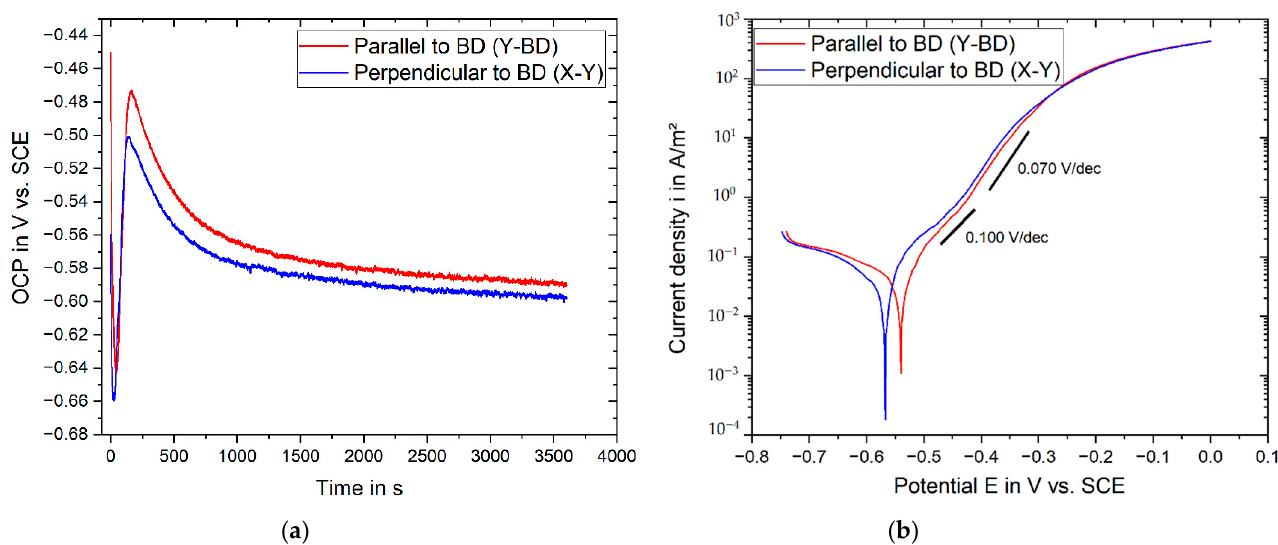
Figure 6. Potentiodynamic polarization measurements in corrected simulated body fluid of LPBF-processed FeMnCS with sample surfaces oriented parallel and perpendicular to BD with ( a ) the open circuit potential (OCP) for 1 h and ( b ) the corresponding Tafel diagrams.